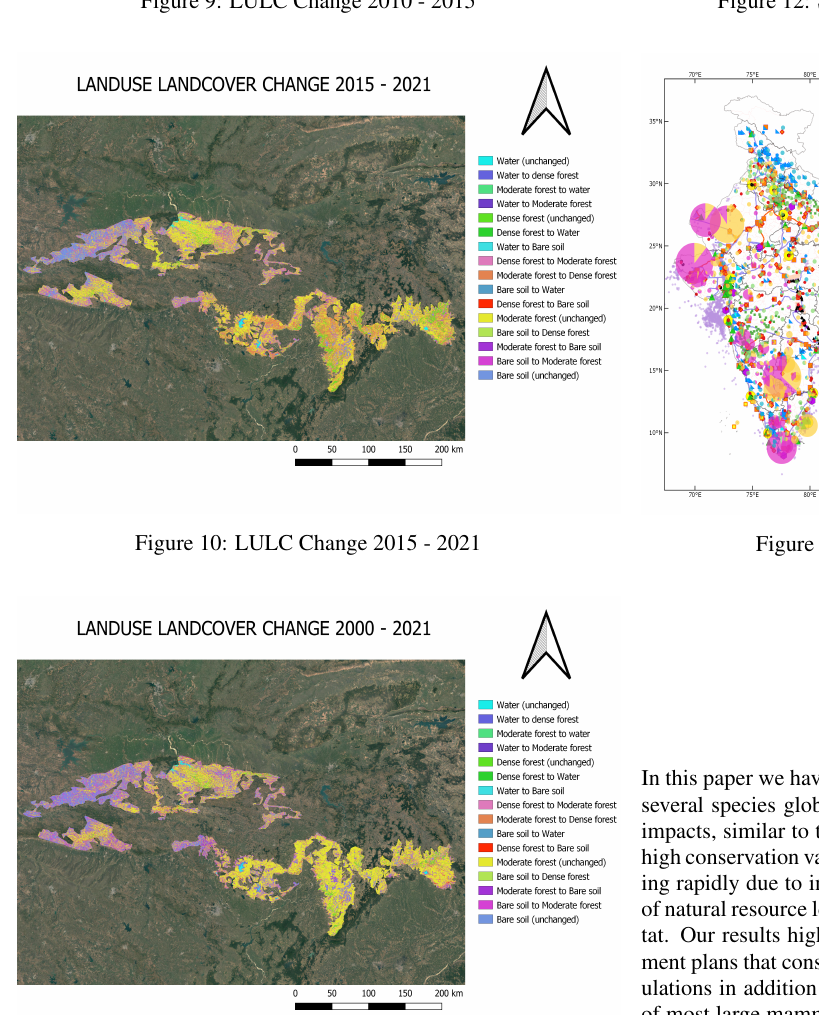
Figure 9: LULC Change 2010 - 2015